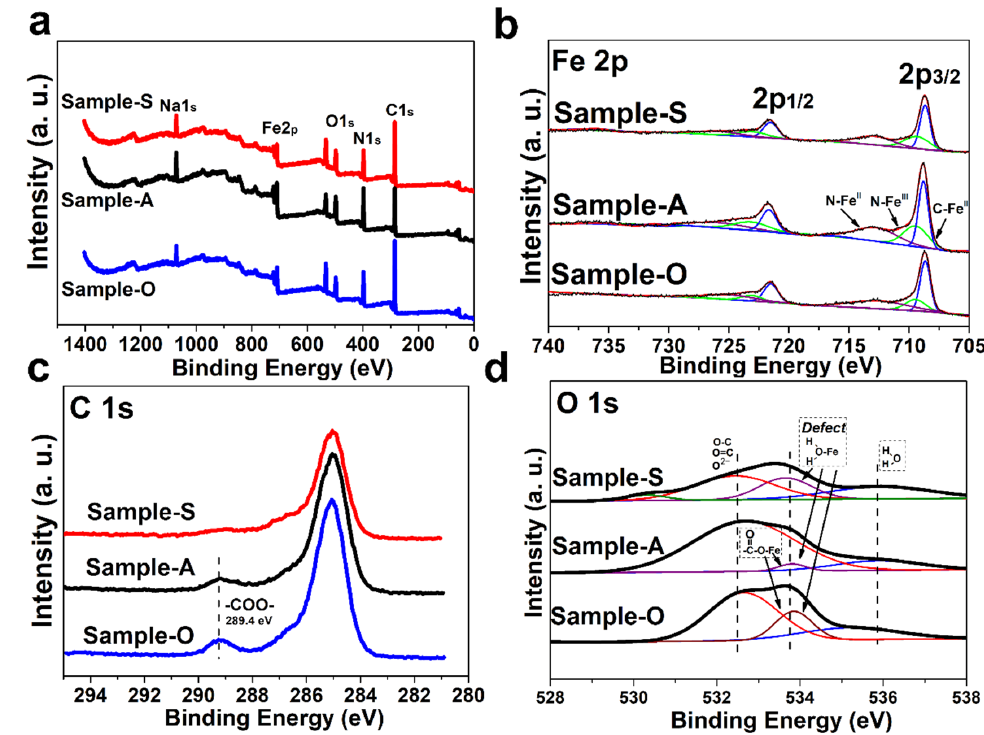
Figure 2. ( a ) XPS wide-scan survey spectrum of all the samples. ( b ) Fe 2p narrow-scan survey spectrum of all the samples. ( c ) C 1s narrow-scan survey spectrum of all the samples. ( d ) O1s narrow-scan survey spectrum of all the samples.